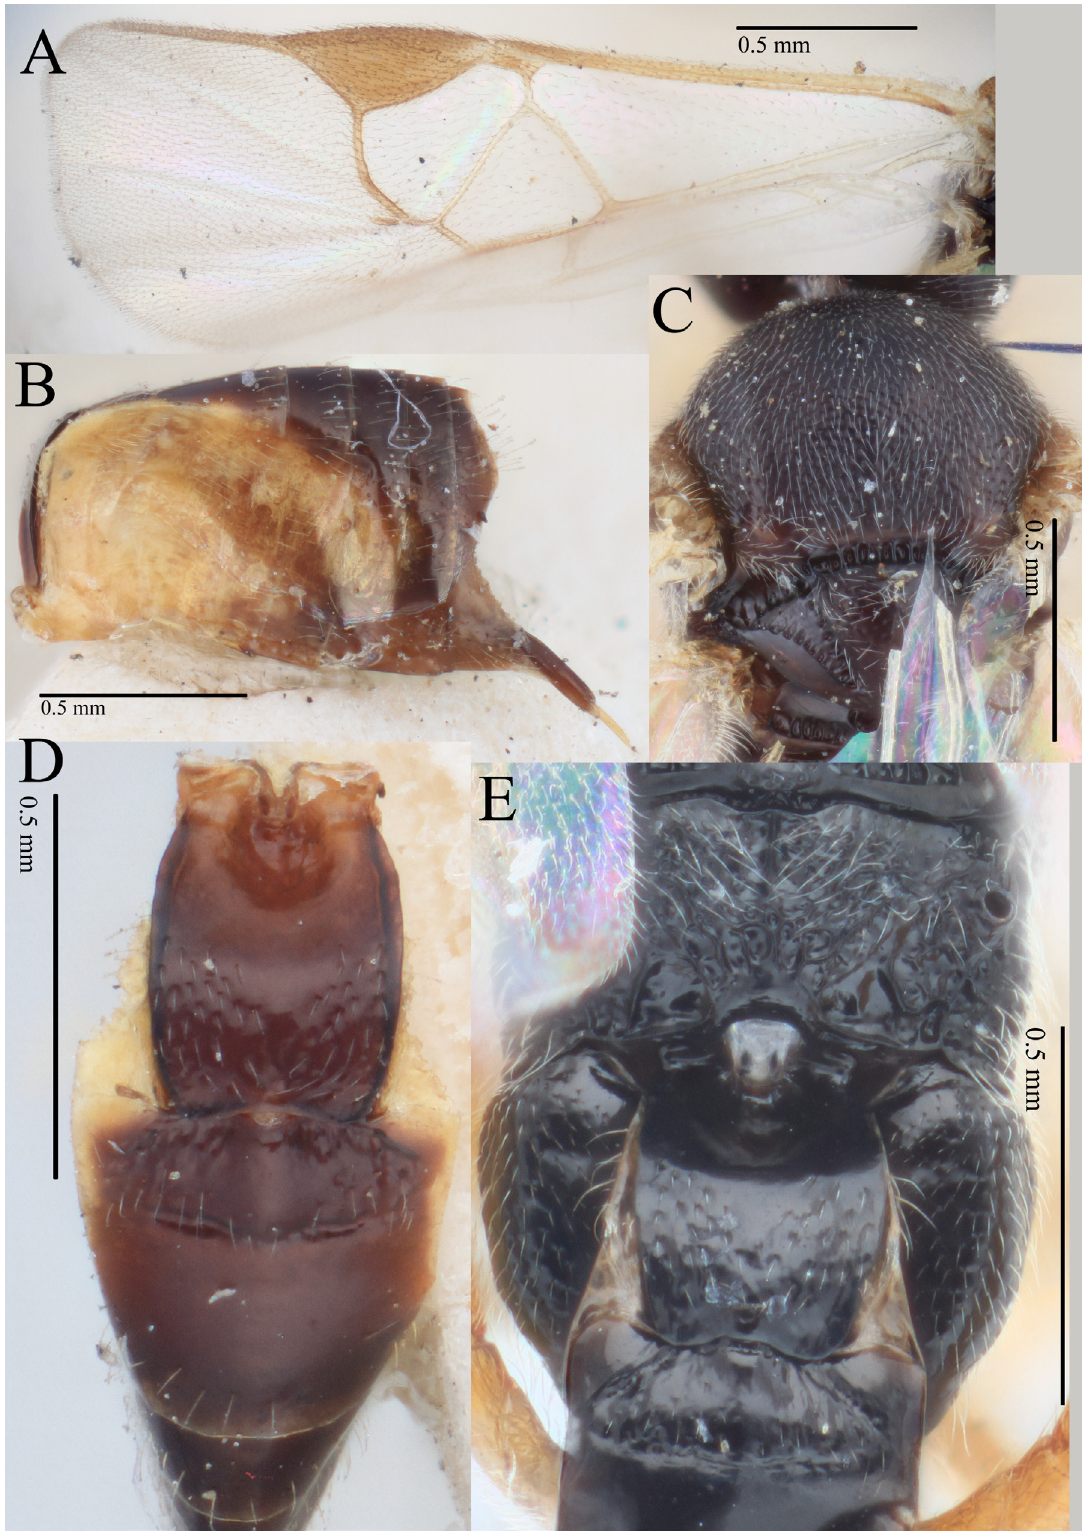
Fig. 15. A–D . Cotesia deliadis (Bingham, 1906), paralectotype (NHMUK). A . Fore wing. B . Metasoma in lateral view. C . Anteromesoscutum. D . Metasoma in dorsal view. E . C. deliadis from Victoria (WINC), with propodeum and T1–2 showing darker